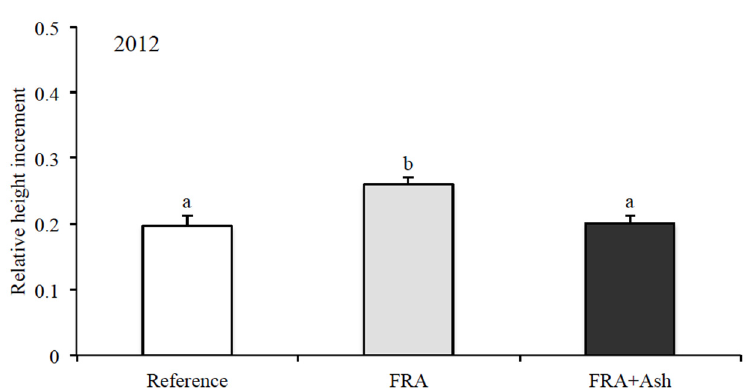
Figure 4. Relativized height increment with standard error for the third growing season (2012). Reference is the standard mine reclamation technique, FRA is the modified Forestry Reclamation Approach, and FRA + Ash is the modified Forestry Reclamation Approach with an addition of bottom ash from the on-site coal burning power plant. Lowercase letters indicate significant differences in relative height increment between soil reclamation